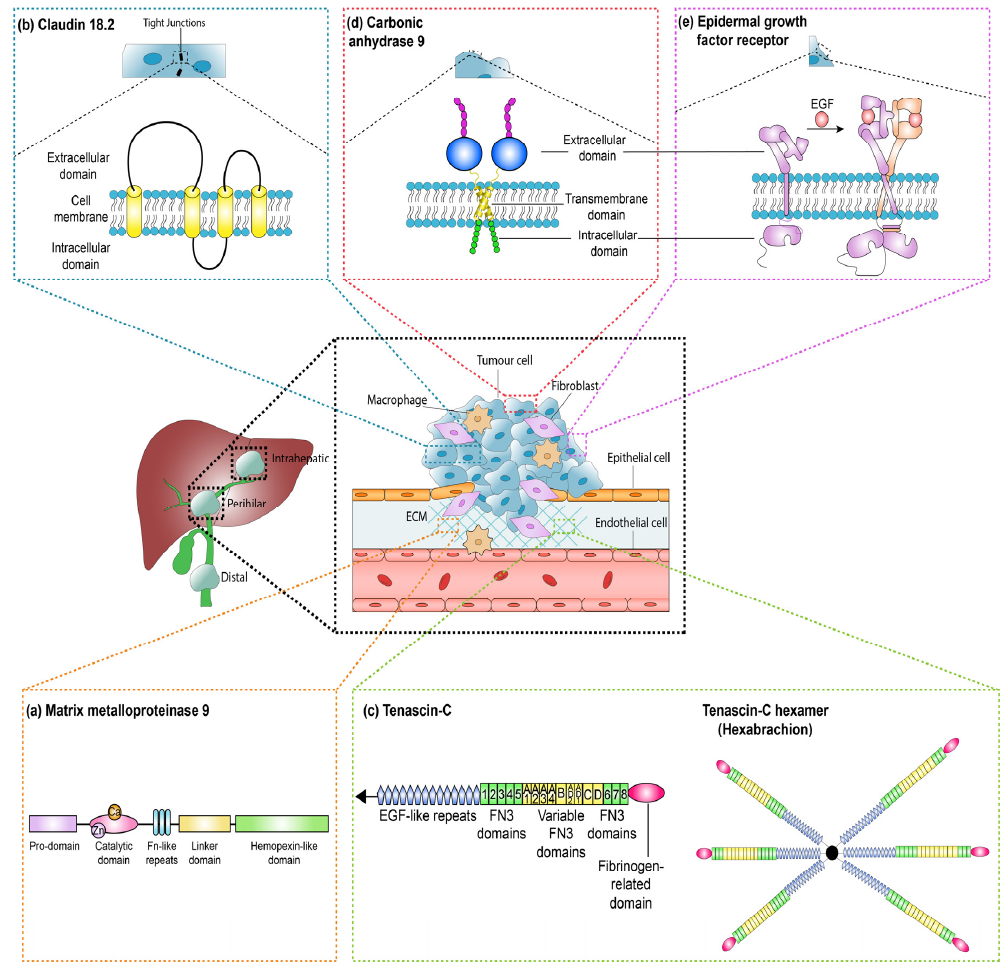
Figure 5. Schematic of the cellular location of MMP9, CLDN18.2, TNC, CA9, and EGFR. ( a ) MMP9 is present in the extracellular matrix (ECM). Schematic shows the different binding domains of MMP9. ( b ) Claudin 18.2 is present in the tight junctions and cell membrane. Schematic shows the two predicted extracellular loops and intracellular loop of Claudin 18.2. ( c ) Tenascin-C (TNC) is a large protein that exists as a hexamer in the ECM. Schematic (on the left) showing the five different domains of TNC from the N-terminus EGF-like repeats, fixed fibronectin domain, variable fibronectin domain, fixed fibronectin domain, and C-terminus fibronectin head. Schematic on the right shows the TNC hexamer, called hexabrachion. ( d ) CA9 is present in the cell membrane. ( e ) EGFR is present in the cell membrane. Schematic shows the inactive form of EGFR which dimerises on binding of Epidermal growth factor (EGF) to its active form.